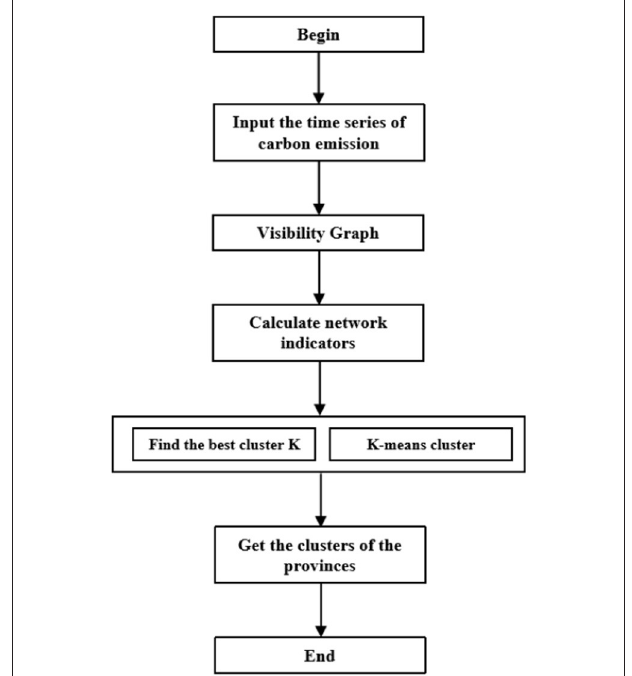
FIGURE 2 | Flow chart of research on carbon dioxide emissions in